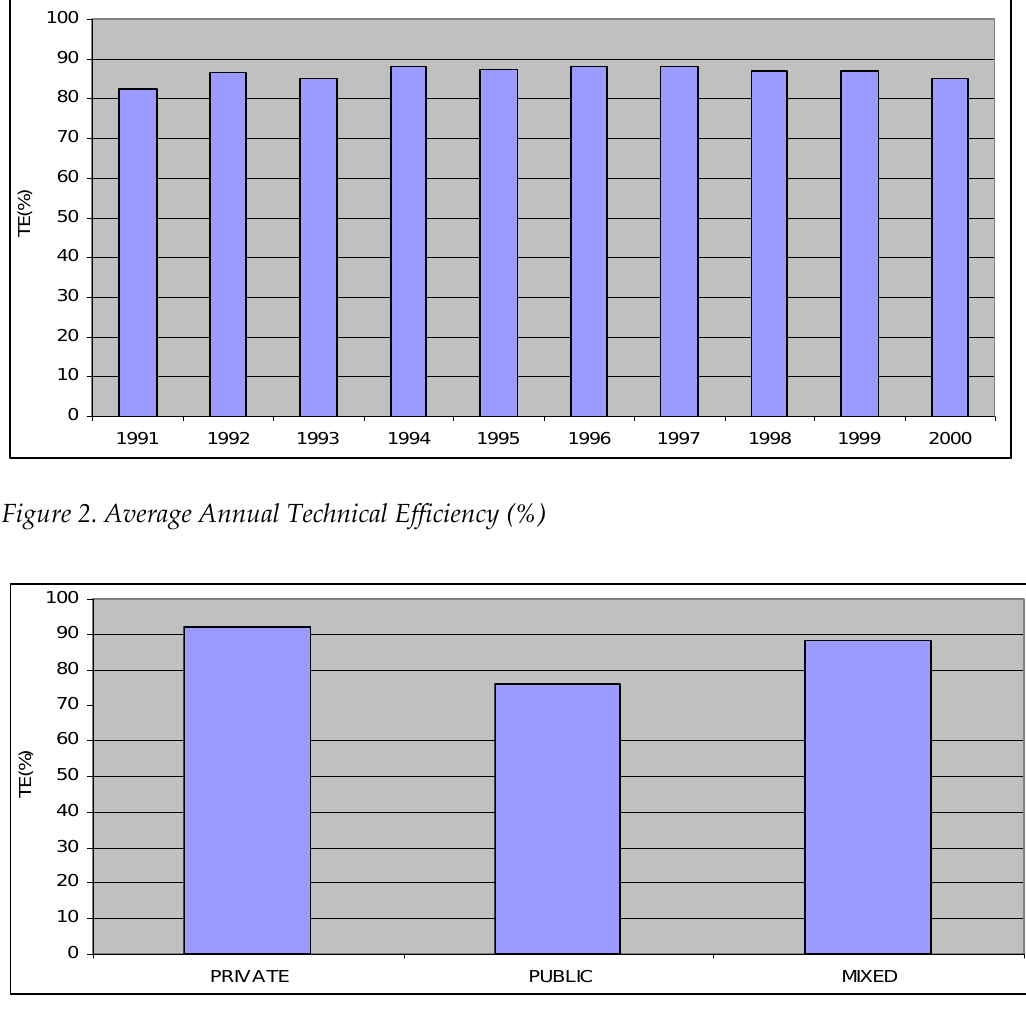
Figure 3. Average Technical Efficiency (%) per State